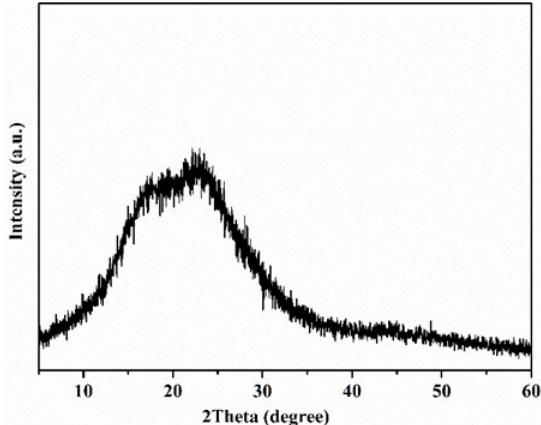
Figure 2. 1 H NMR ( left ) and 13 C NMR ( right ) spectra of the BCPD monomer. Figure 3. WAXD curve of the BCPD monomer. Figure 3. WAXD curve of the BCPD